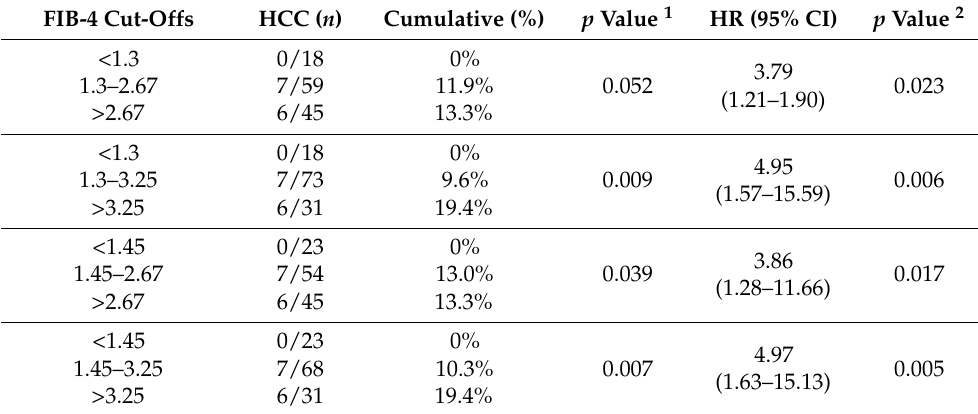
Figure 2. Distribution of NIT values (( A ): AAR; ( B ): APRI; ( C ): FIB-4; ( D ): BARD) in the study cohort. Dots represent individual values, while red triangles represent median values. Abbreviations: AAR, AST/ALT ratio; APRI, AST to platelet ratio index; FIB-4, fibrosis 4. Table 2. Cumulative probability and hazard ratios of HCC according to FIB-4 risk category.